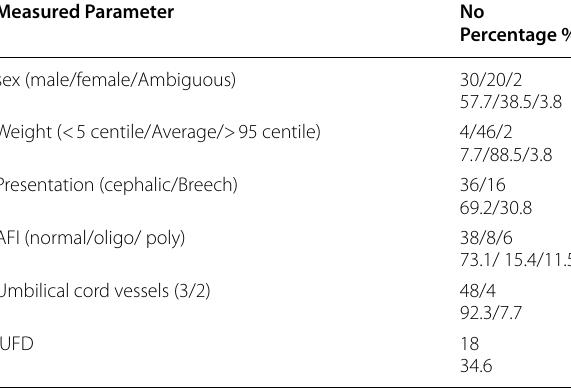
Table 3 Number and percentage of fetal parameters